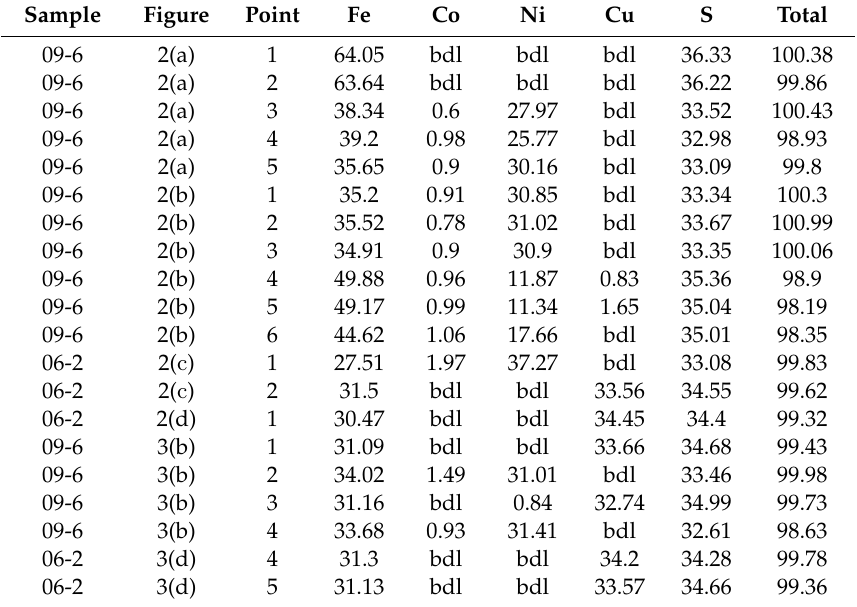
Table 1. Electron-microprobe data (wt. %) on sulfide associated with rhenium minerals.